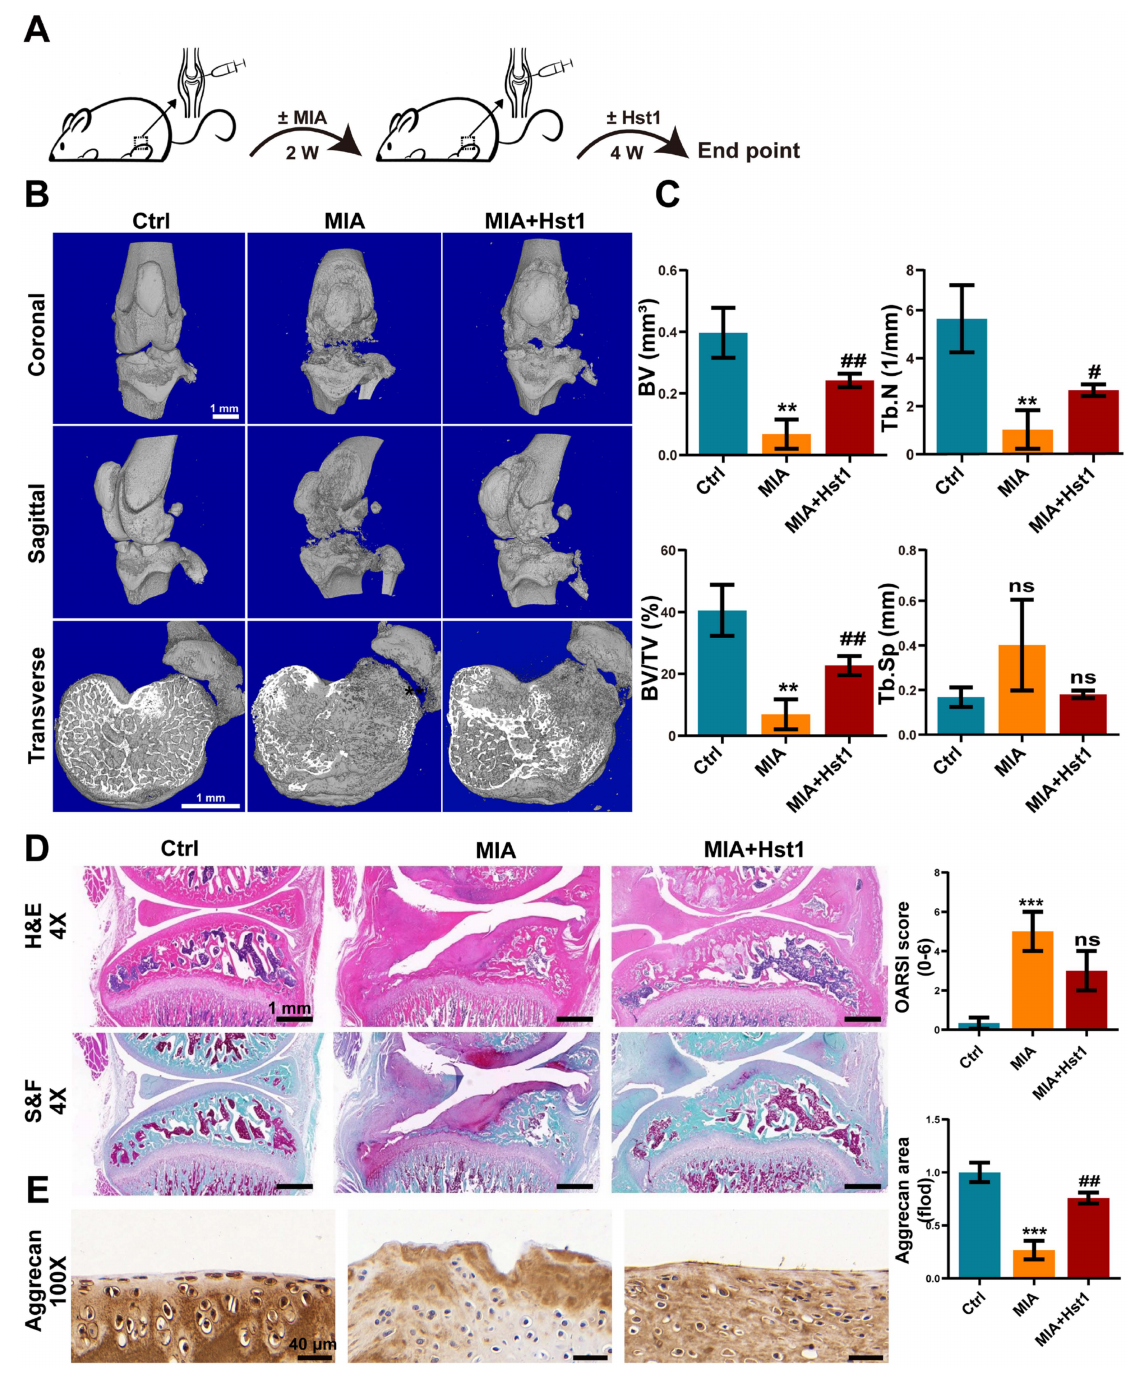
Figure 1. Hst1 attenuated bone and cartilage damage in MIA-induced knee OA. ( A ) The procedure of creating the rat knee OA model and administering Hst1 treatment. ( B ) Three-dimensional micro-CT images of the transverse section, coronal, and sagittal planes of the knee joint, scale bar = 1 mm. ( C ) Quantitative analysis of skeletal parameters BV, BV/TV, Tb. N, and Tb.Sp. ( D ) Knee joint tissue sections were stained with S&F and H&E, and OARSI was used for quantitative analysis, scale bar = 1 mm. ( E ) Representative images of Aggrecan immunohistochemical staining of knee joint tissue sections, scale bar = 40 µ m. Data are expressed as means ± SD from three independent experiments. Significant differences compared to control group: ** p < 0.01 and *** p < 0.001, and compared to MIA group: # p < 0.05 and ## p < 0.01; ns: not